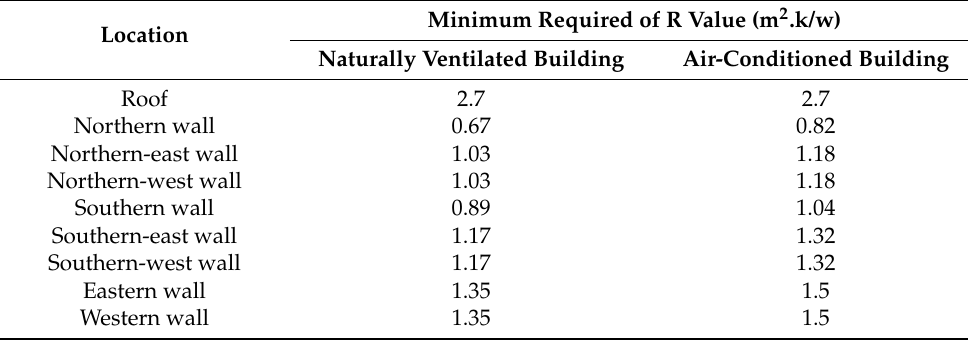
Table A1. Minimum requirements of resistance value (R) for Cairo climate [32].